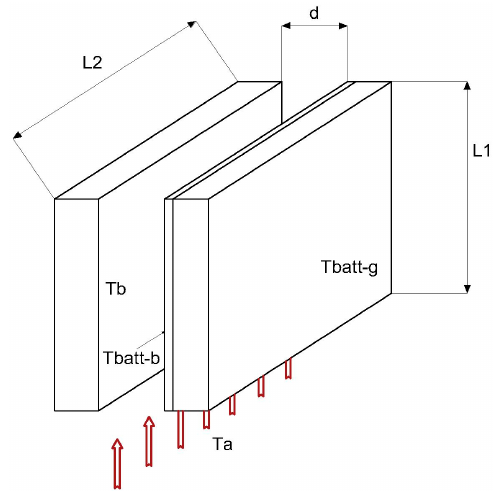
Figure 4. Natural convection between plane plates (i.e., backsheet and battery). d is the distance between the PV unit and the battery; T b is the temperature of backsheet; and T batt-b is the temperature of the battery; Ta is the temperature of the air; L 1 and L 2 are the dimensions of the first and the second plane, respectively.